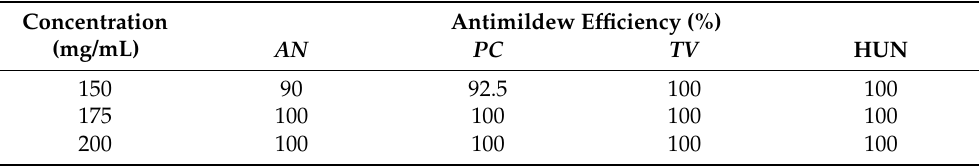
Table 2. Efficacy of different concentrations of tea-polyphenols-citral on the mildew treatment of